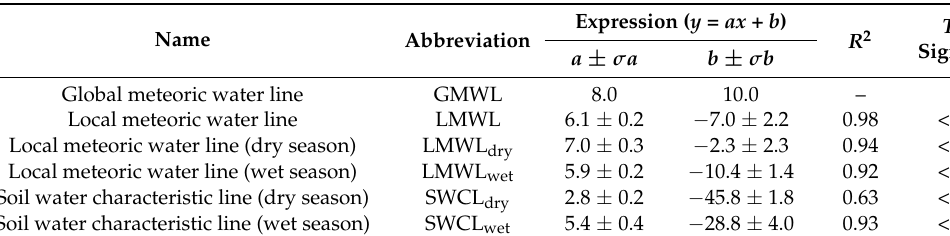
Table 1. The basic characteristics of each characteristic curve.